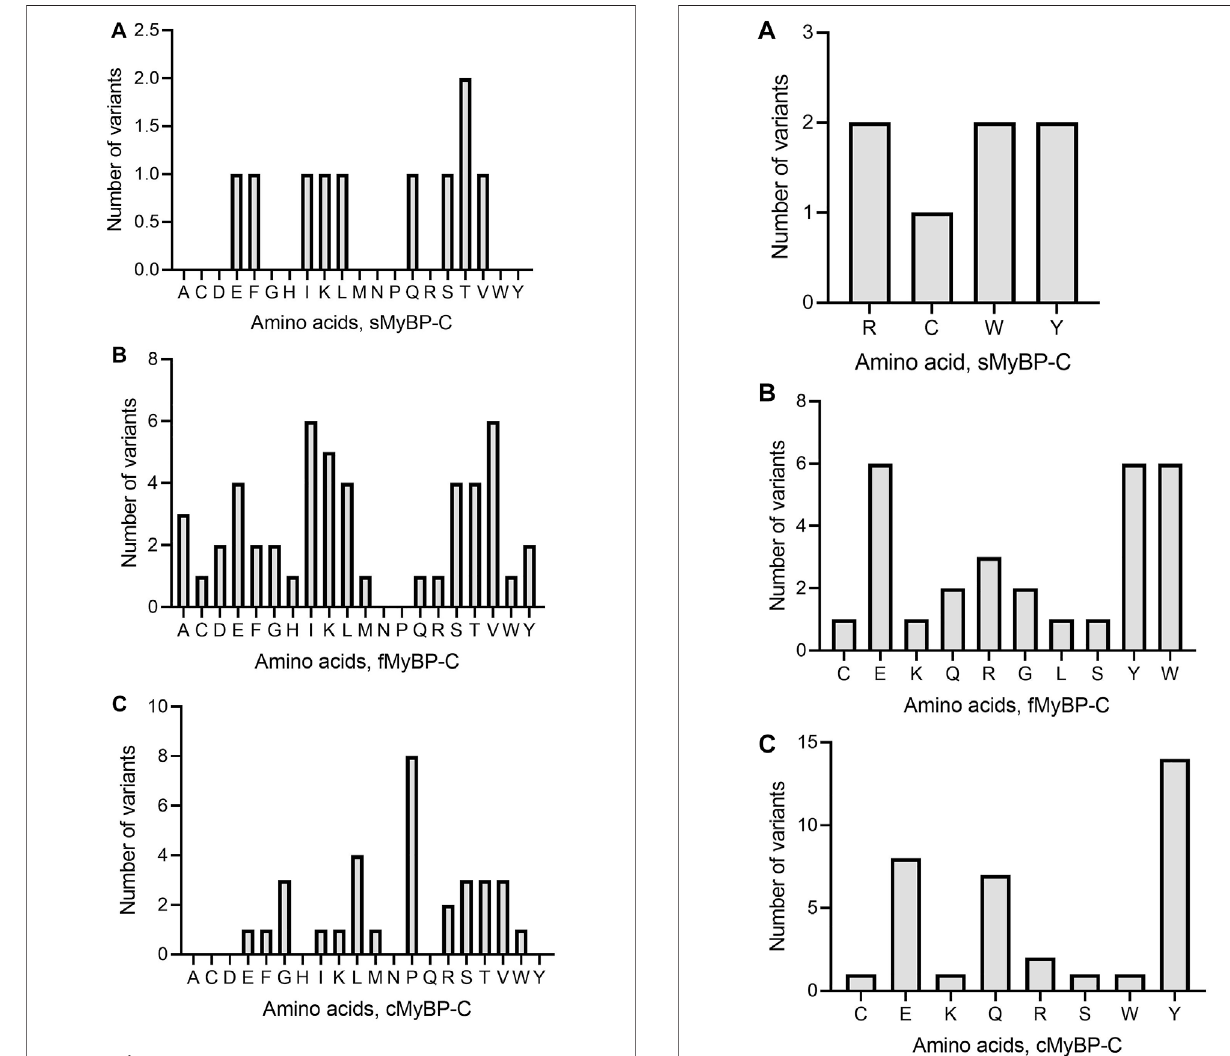
FIGURE 6 | Prevalence of amino acids in frameshift variants in the MyBP-C gene family. Thr (T), Iso (I) and Pro (P) were the most mutated amino acids in frameshift variants in sMyBP-C (A) , fMyBP-C (B) and cMyBP-C (C) proteins, respectively.